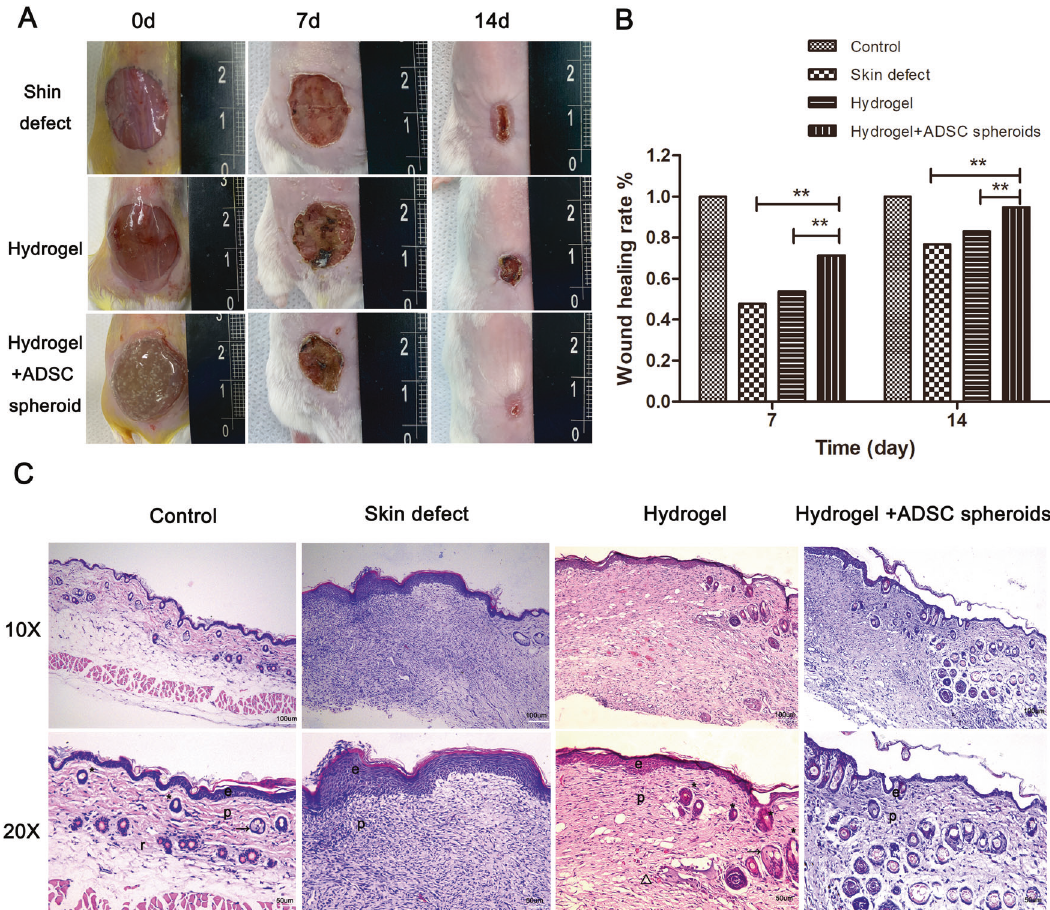
Fig. 3 The DA-MeHA hydrogel encapsulating spheroids composed of ADSCs accelerated the regeneration of skin defects in mice. A Images captured on the 7th and 14th days after surgery showed that the skin defect healed remarkably faster after treatment with DA- MeHA hydrogel-encapsulated spheroids composed of ADSCs than the other groups. B Wound healing rates. The wound healing rate of the hydrogel + ADSCs spheroid group was signi fi cantly higher than that of the skin defect group and hydrogel group. C HE staining showed that the structure and morphology of the regenerated epidermis and dermis in the hydrogel + ADSCs spheroid group were closest to those of the control group, followed by the hydrogel group. Abbreviations: e epidermis, p papillary dermis, and r reticular dermis. Arrowheads indicate sebaceous glands and asterisks indicate hair bulbs (* p < 0.05 and ** p <